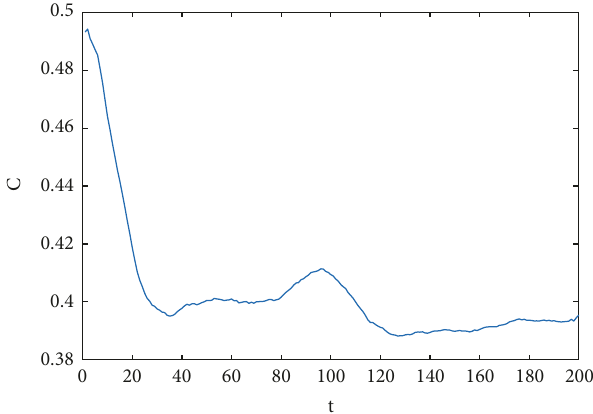
Figure 6: The evolution picture of the collaborative innovation network average clustering coefficient.